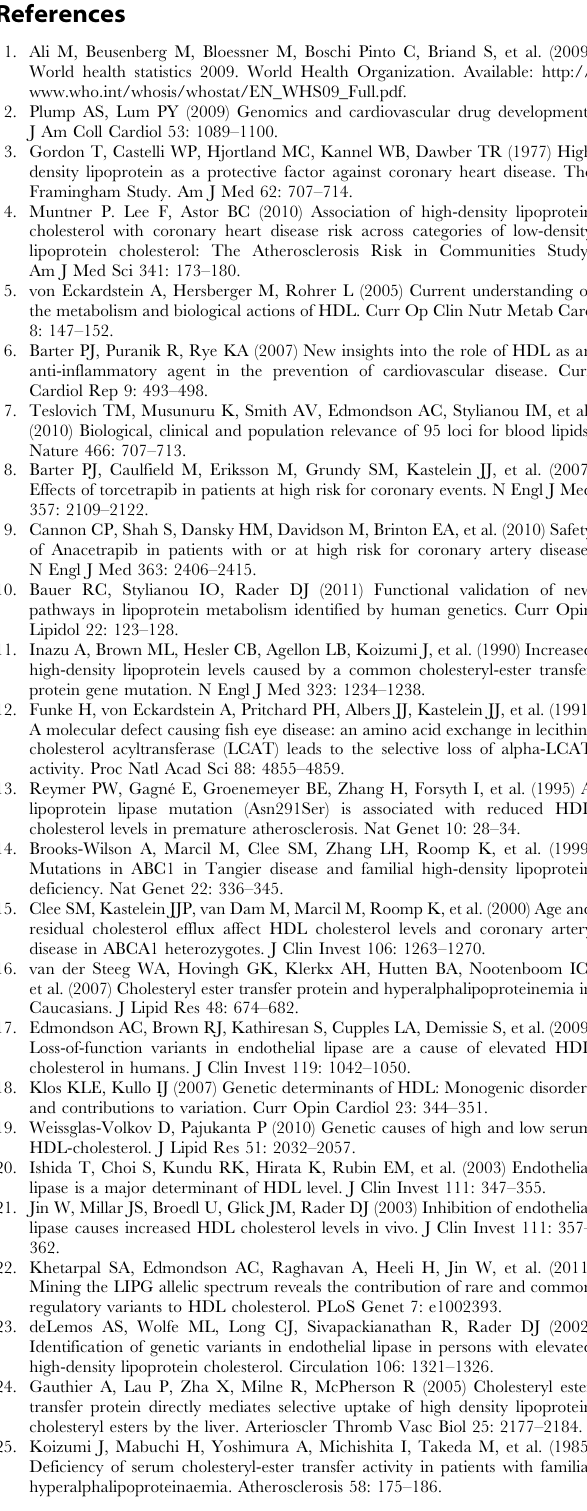
Table S6 Association of LIPG + GALNT2 mutations with HDLc in families. Table S7 PCR primer